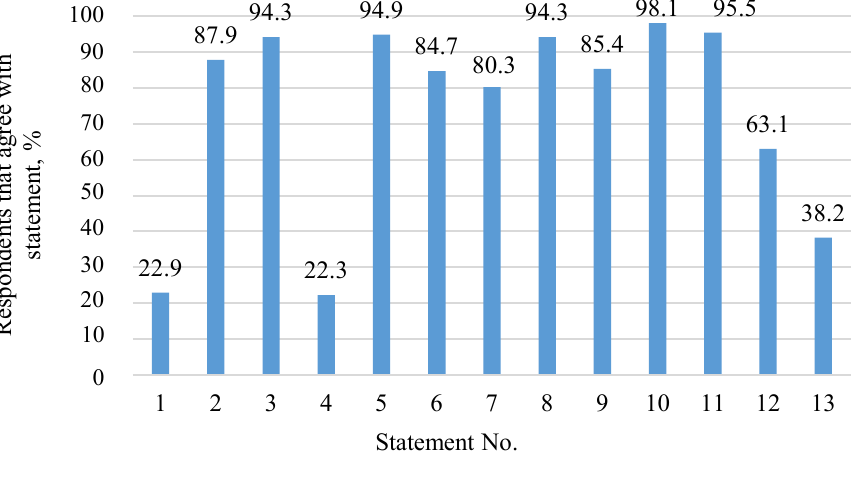
Fig. 1. Respondents that agree with statements in group “Environmental